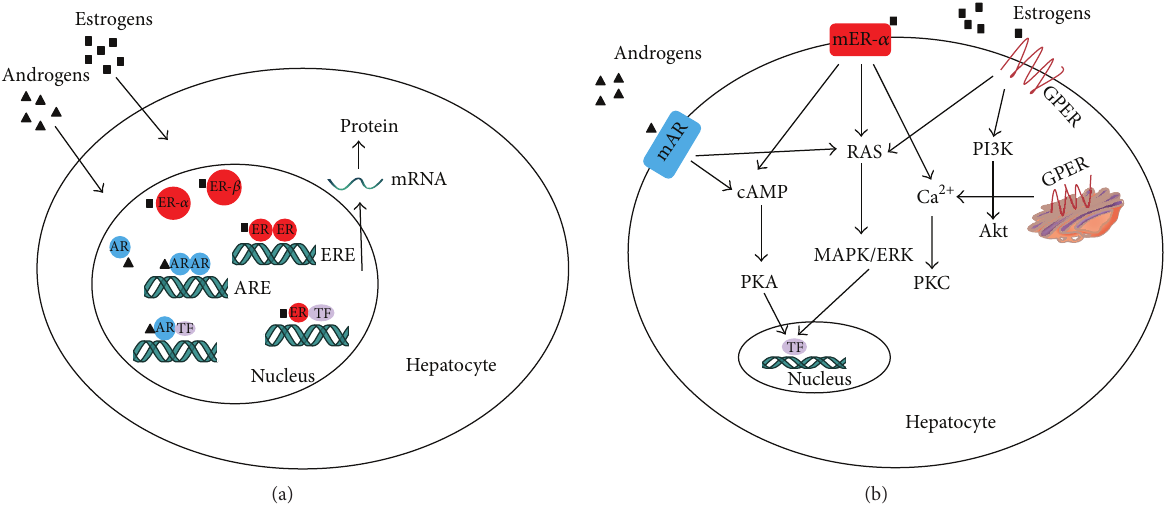
Figure 1: Action of estrogens and androgens via estrogen receptors (ERs) and androgen receptors (ARs) in the liver cells. (a) Genomic effects of estrogens and androgens via nuclear ERs and ARs. (b) Nongenomic effects of estrogens and androgens via membrane-associated ERs and